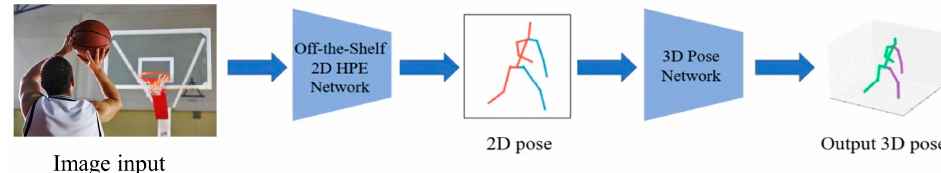
Figure 3. Fitting 3D coordinates of human joints with 2D coordinates of human joints.